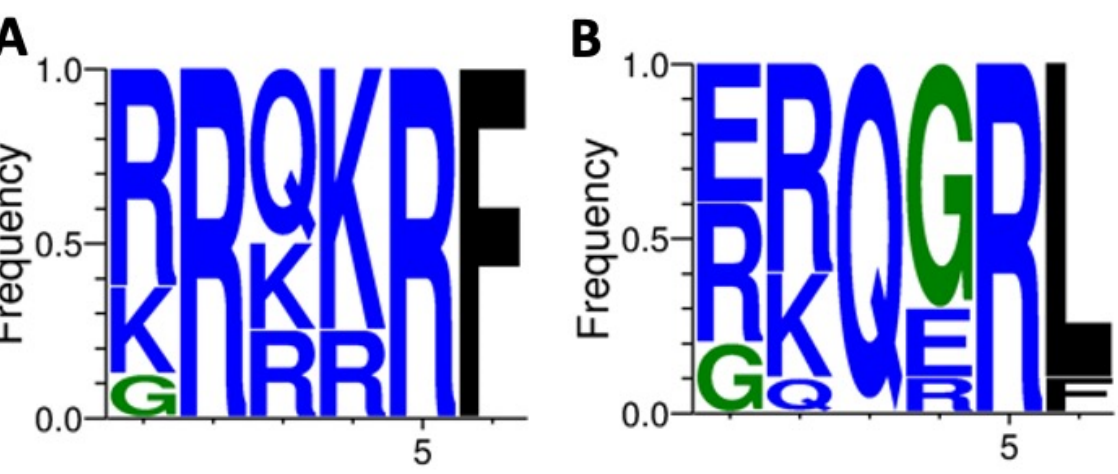
Figure 3. Sequence analysis of F protein cleavage site in NDV isolates. The diversity of residues at each position of the fusion cleavage site was analyzed using WebLogo 3.1 (http://weblogo. threeplusone.com/create.cgi (accessed on 28 April 2022)). Frequency of amino acid residues from the F protein fusion cleavage site motif of virulent NDV natural isolates, representative of 1073 isolates ( A ). Frequency of amino acid residues from the F protein fusion cleavage site motif of avirulent NDV natural isolates, representative of 499 isolates ( B ). The motif 112 RRQKR ↓ F 117 from NDV/pi- geon/PE-Brazil/MP003/2018 lies with virulent strains and is the most common motif observed from 801 strains as reported by Wang et al., 2017 [23].